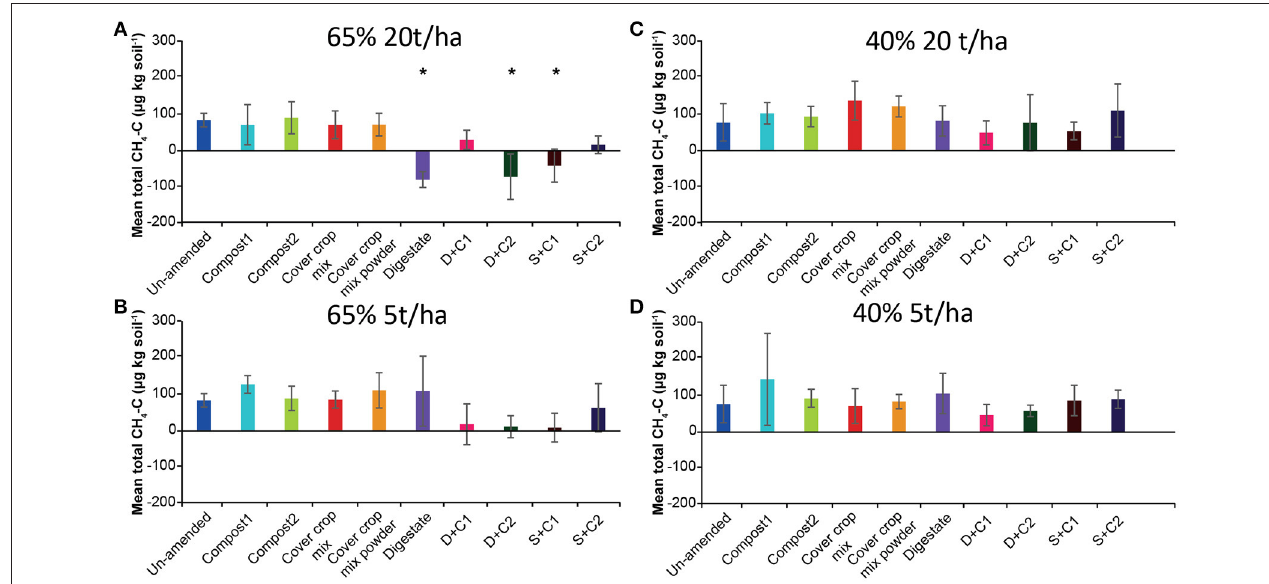
FIGURE 1 | Mean total CH 4 emitted or consumed over the period of 28 d in un-amended clay soil and after amendments with compost1, compost2, CC residues mixtures, digestate, digestate + compost1, digestate + compost2, sewage sludge + compost1, and sewage sludge + compost2 (mean ± SD; n = 3) at (A) high amount (20 t/ha) and high water content (65%), (B) low amount (5 t/ha) and high water content, (C) high amount and low water content (40%), and (D) low amount and low water content, derived from the cumulative CH 4 ( Supplementary Figure 1 ) fluxes. Asterisk (*) indicate significant differences in the mean total CH 4 fluxes between the soils with organic amendments and the un-amended soil within the four separate superordinate treatments (ANOVA: P < 0.05).